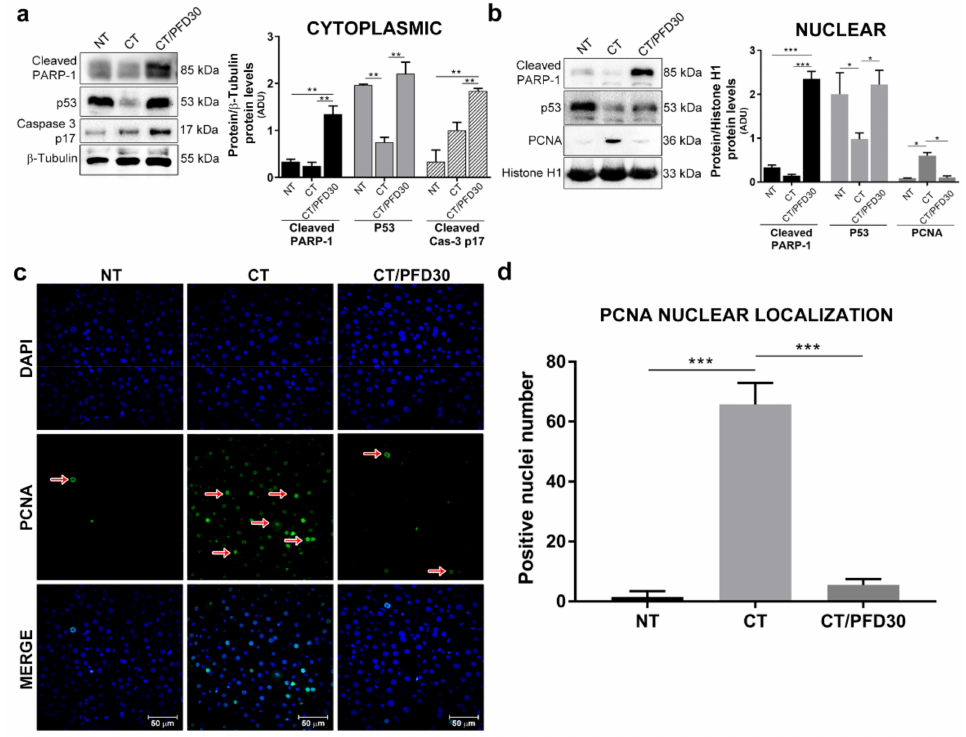
Figure 5. Activation markers of pro-apoptotic pathway in MRHM by PFD. ( a ) PARP-1 p85, p53 and caspase-3 p17 expression in cytoplasm. ( b ) PARP-1 p85, p53 and PCNA nuclear expression. ( c ) IF